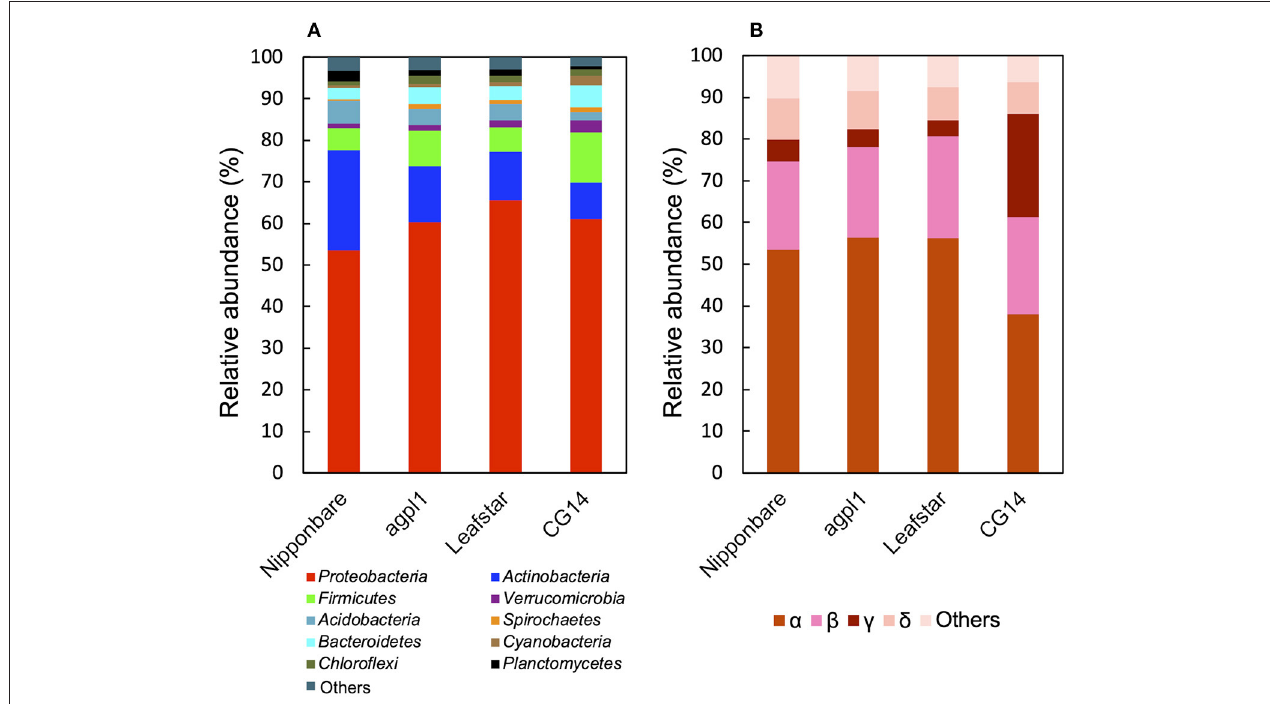
FIGURE 5 | Relative abundance of the phylum (A) , subdivision of Proteobacteria (B) based on 16S rRNA gene sequence in the stems of four rice genotypes at the heading stage in field experiment in 2018. Mean relative abundance of the 16S-OTUs in each rice genotype was used for calculations ( n = 2 for Nipponbare and CG14; n = 3 for agpl1 and Leafstar). The letters α , β , γ , and δ indicate alpha, beta-, gamma-, and delta-proteobacteria,